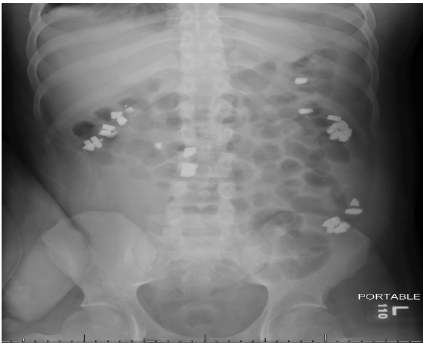
Figure 3: KUB from 7/4/18 shows new radiopaque foreign material in bowel concerning for foreign